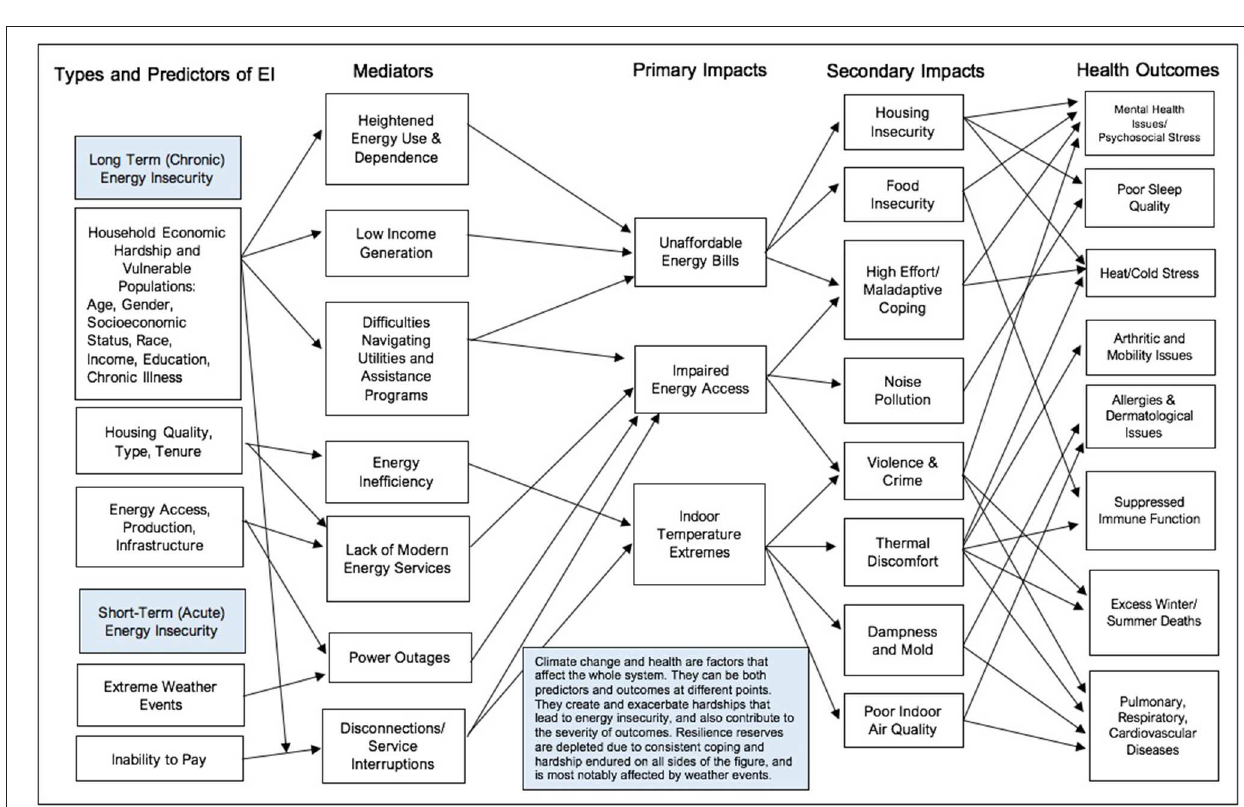
FIGURE 2 | Connection between household energy insecurity (EI) and health.